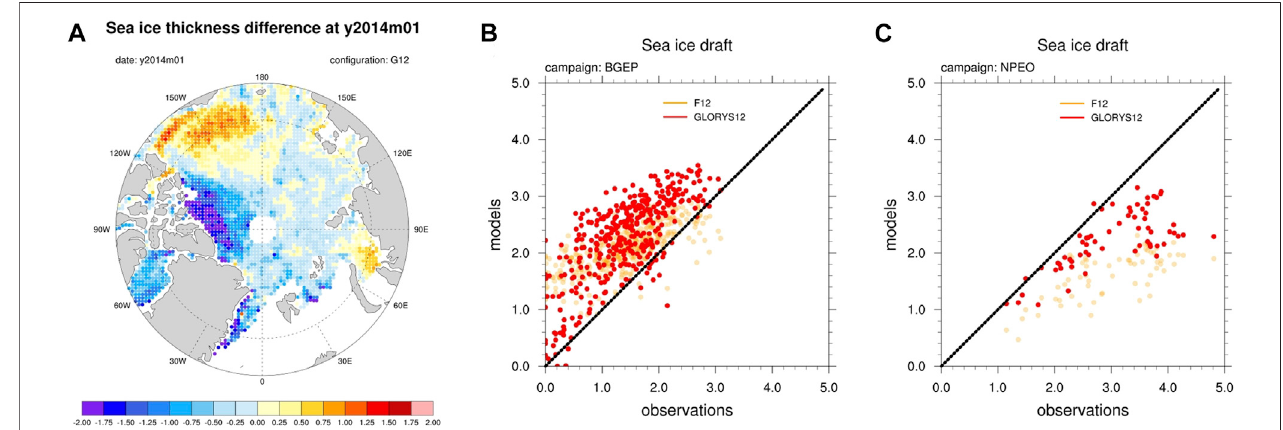
FIGURE5|(A) Differencesofseaice thicknessbetweenGLORYS12 and Cryosat-2 data(Rickeret al.,2014).Modelversusobservationsplots ofsea icedrafts on a linear scale with GLORYS12 (red) and F12 (orange) and in situ observations from (B) BGEP (Beaufort Gyre Exploration Project, (Krish fi eld et al., 2014)) campaign, (C) NPEO (North Pole Environment Observatory, (Drucker et al., 2003))